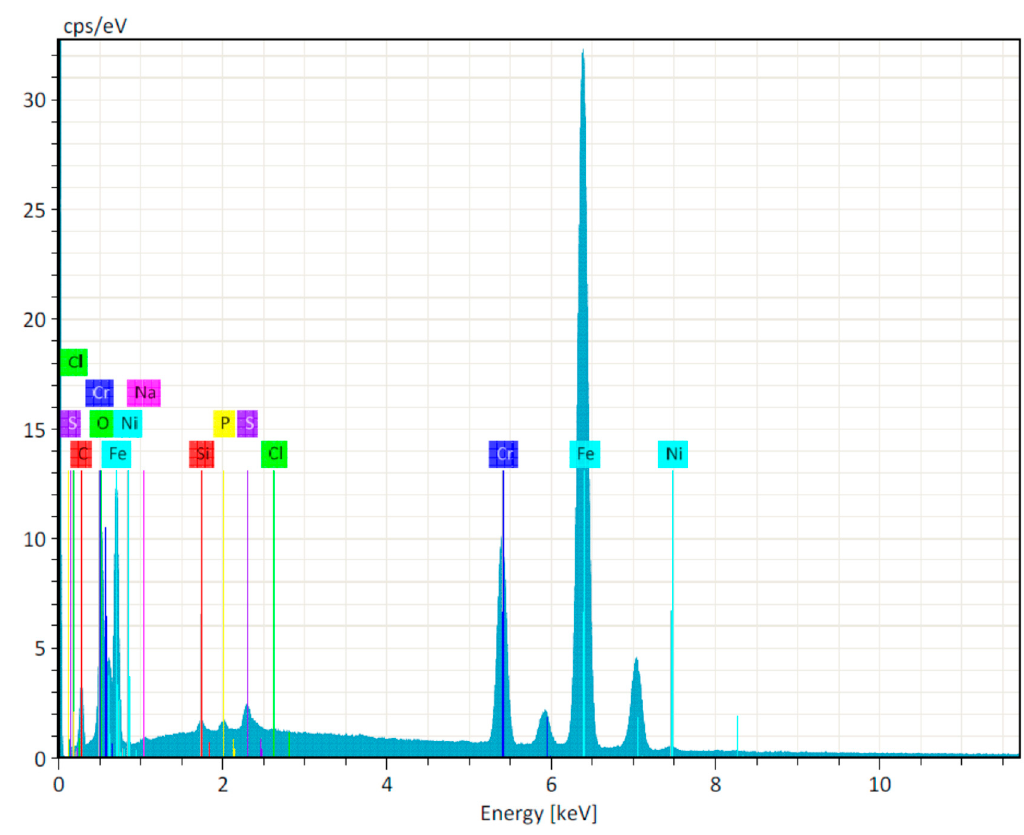
Figure 3. Spectra showing elemental peaks of the new drill surface. Figure 1. Spectra showing elemental peaks of the new drill surface. Figure 1. Spectra showing elemental peaks of the new drill surface.